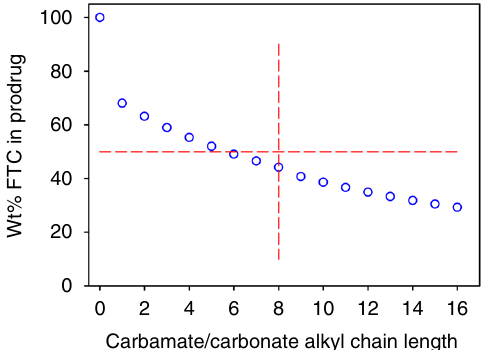
Fig. 6 Reduction of parent emtrictabin (FTC) content with increasing alkyl chain length for carbonate/carbamate prodrugs. As a guide, a 50% mass penalty is highlighted by the horizontal red lines and compounds studied here only utilised chain lengths up to 8 carbon atoms (vertical